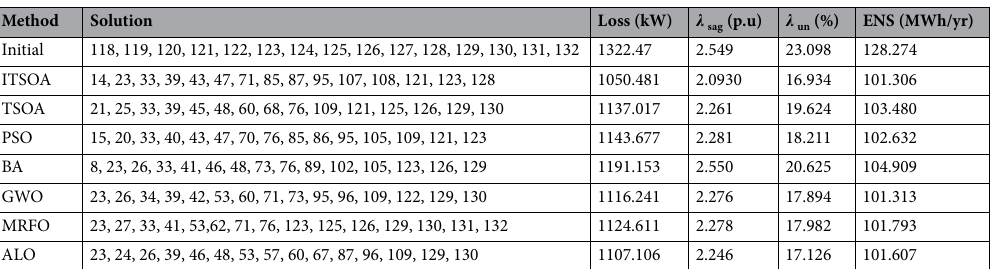
Table 8. Simulation results of multiobjective reconfiguration 118-bus unbalanced network.